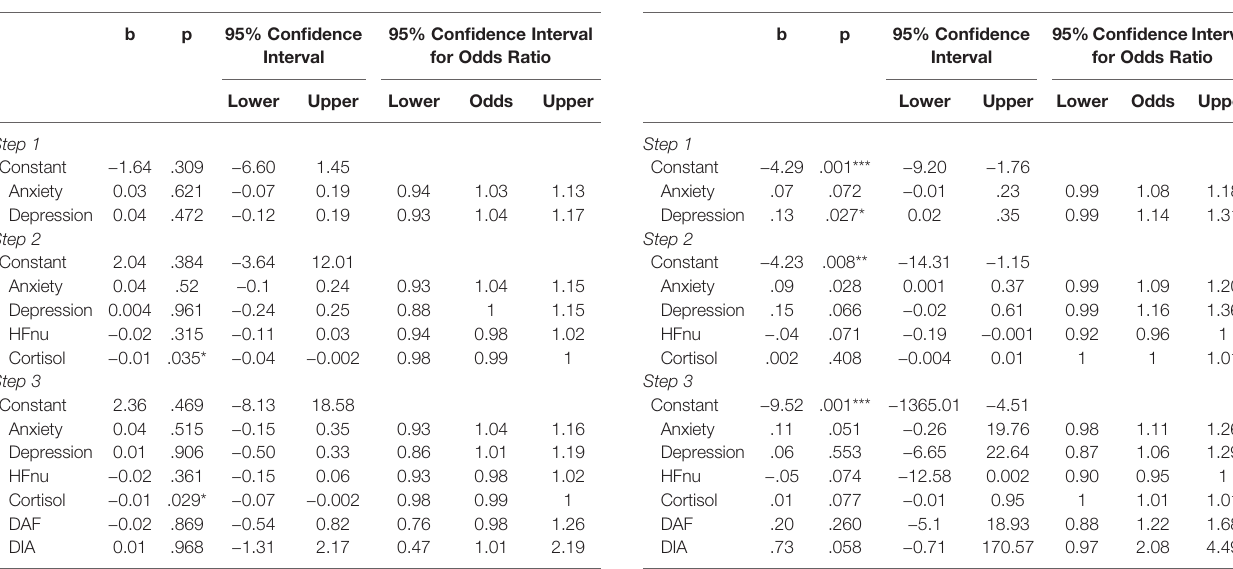
TABLE 4 | Summary of hierarchical logistical regression analysis the presence of Crohn ’ s disease (CD) (95% BCa bootstrap con fi dence intervals based on 5,000